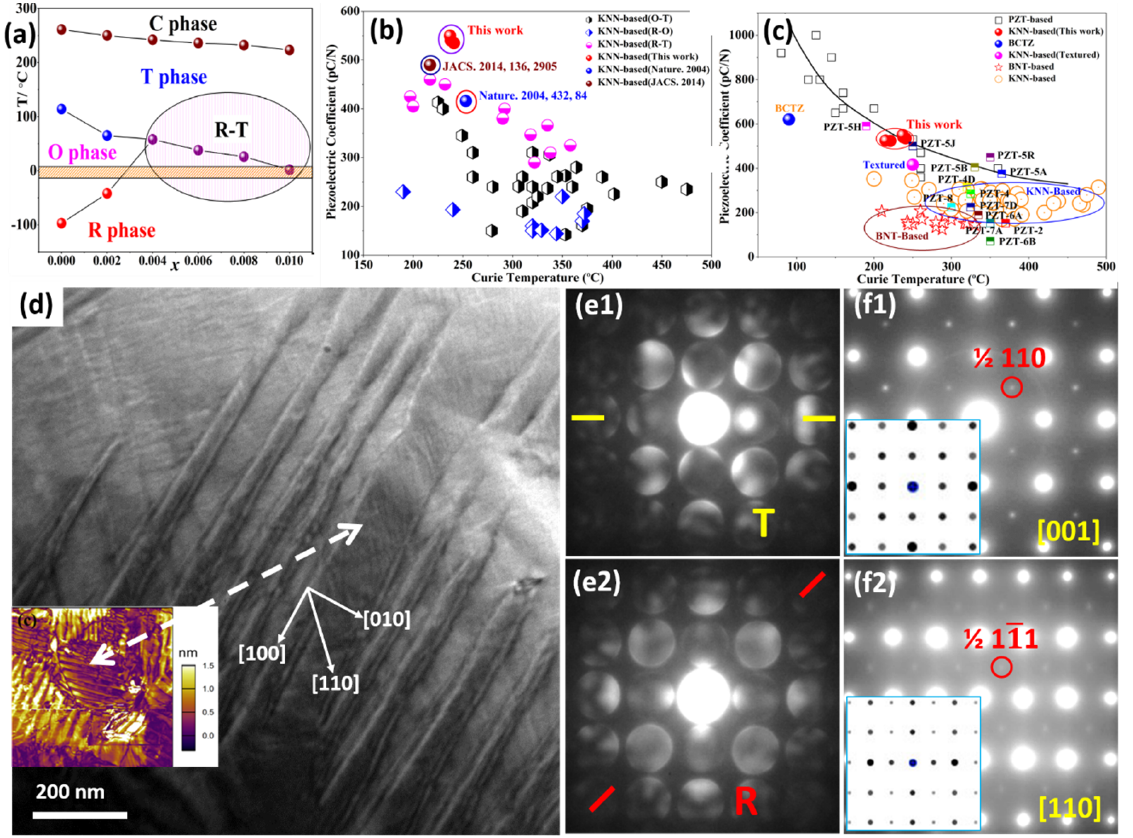
Figure 1. Piezoelectric property optimization via constructing the polymorphic R - T phase boundary in KNN-based materials: ( a ) phase diagram of KNN-based materials with respect to the fraction of BiFeO 3 . ( b , c ) comparison of piezoelectricity as a function of T C of the KNNS-xBF-yBNZ and other lead-based and lead-free piezoceramics. Hierarchical nanodomain structure of KNN-based piezoelectrics: ( d ) TEM image showing structures with hierarchical nanodomain, with a PFM photo inset. ( e1 , e2 ) CBED patterns of adjacent nanodomains, showing mirror planes along {010} and {100} for R phase and T phases, respectively. ( f1 , f2 ) Electron diffraction patterns showing superlattices, with simulated patterns inset. Reproduced from: Ref. [44] Copyright 2016 American Chemical Society; Ref. [114] Copyright 2017 Royal Society of Chemistry.